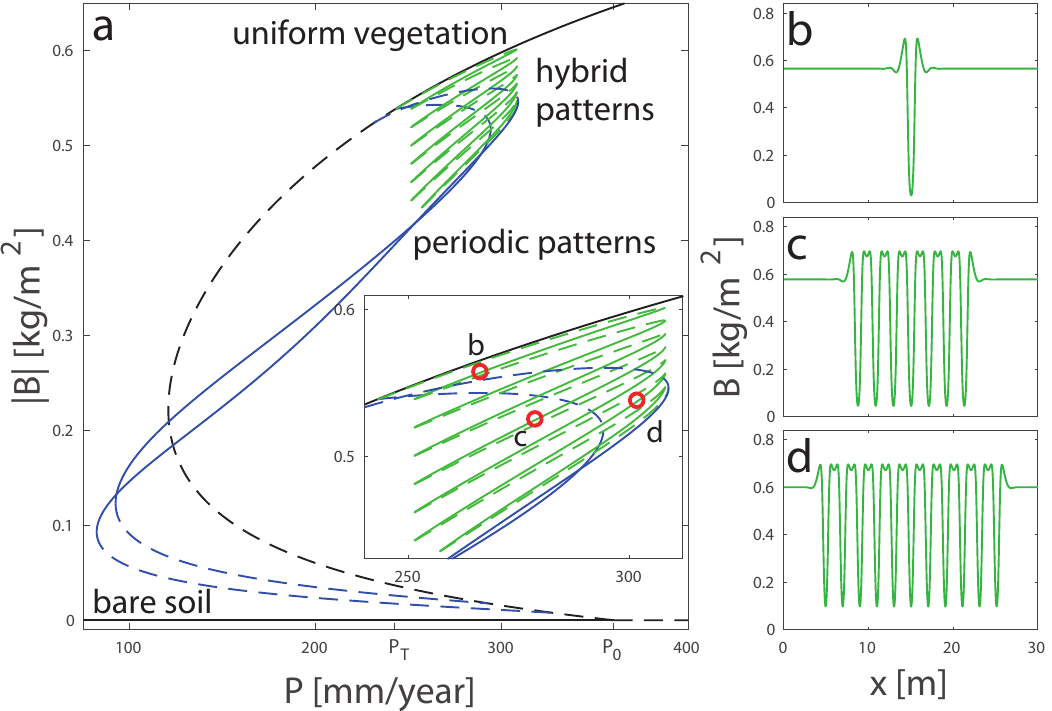
Figure 4. Bifurcation diagram for the model presented in Appendix B (Equation (A17)) in 1D (panel a ). The vertical axis is the spatial biomass average, while the horizontal axis is the precipitation rate. Solid (dashed) lines represent stable (unstable) solutions. The diagram shows bistability precipitation ranges of bare soil and periodic patterns, and of bare soil and uniform vegetation, as well as a tristability range of bare soil, uniform vegetation and periodic patterns. Within the latter range there exists a subrange of hybrid patterns, consisting of confined pattern domains of increasing size in an otherwise uniform vegetation, examples of which are shown in the three panels ( b – d ). Parameters: Λ = 0.1 [(m 2 /kg)/y], Γ = 4 [(m 2 /kg)/y], E = 7 [m 2 /kg], K = 1 [kg/m 2 ], M = 4.5 [1/y], N = 8 [1/y], R = 0.1, D [m 2 /y], D W = 30 [m 2